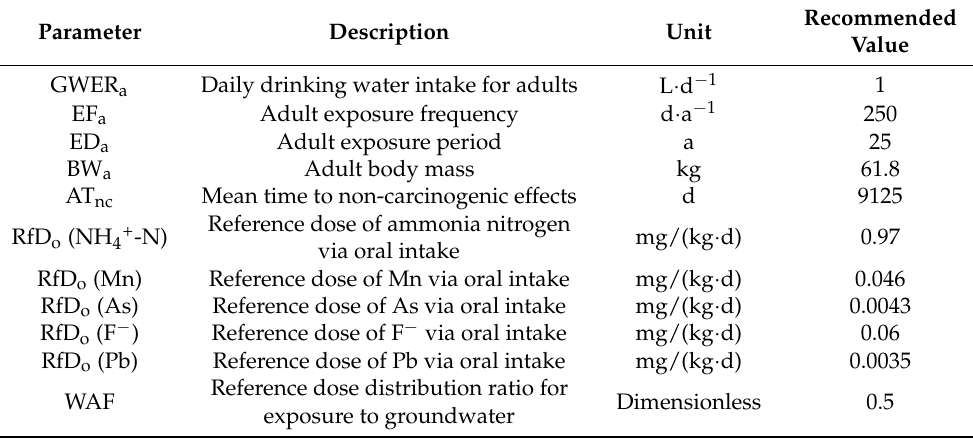
Table 2. Health risk evaluation